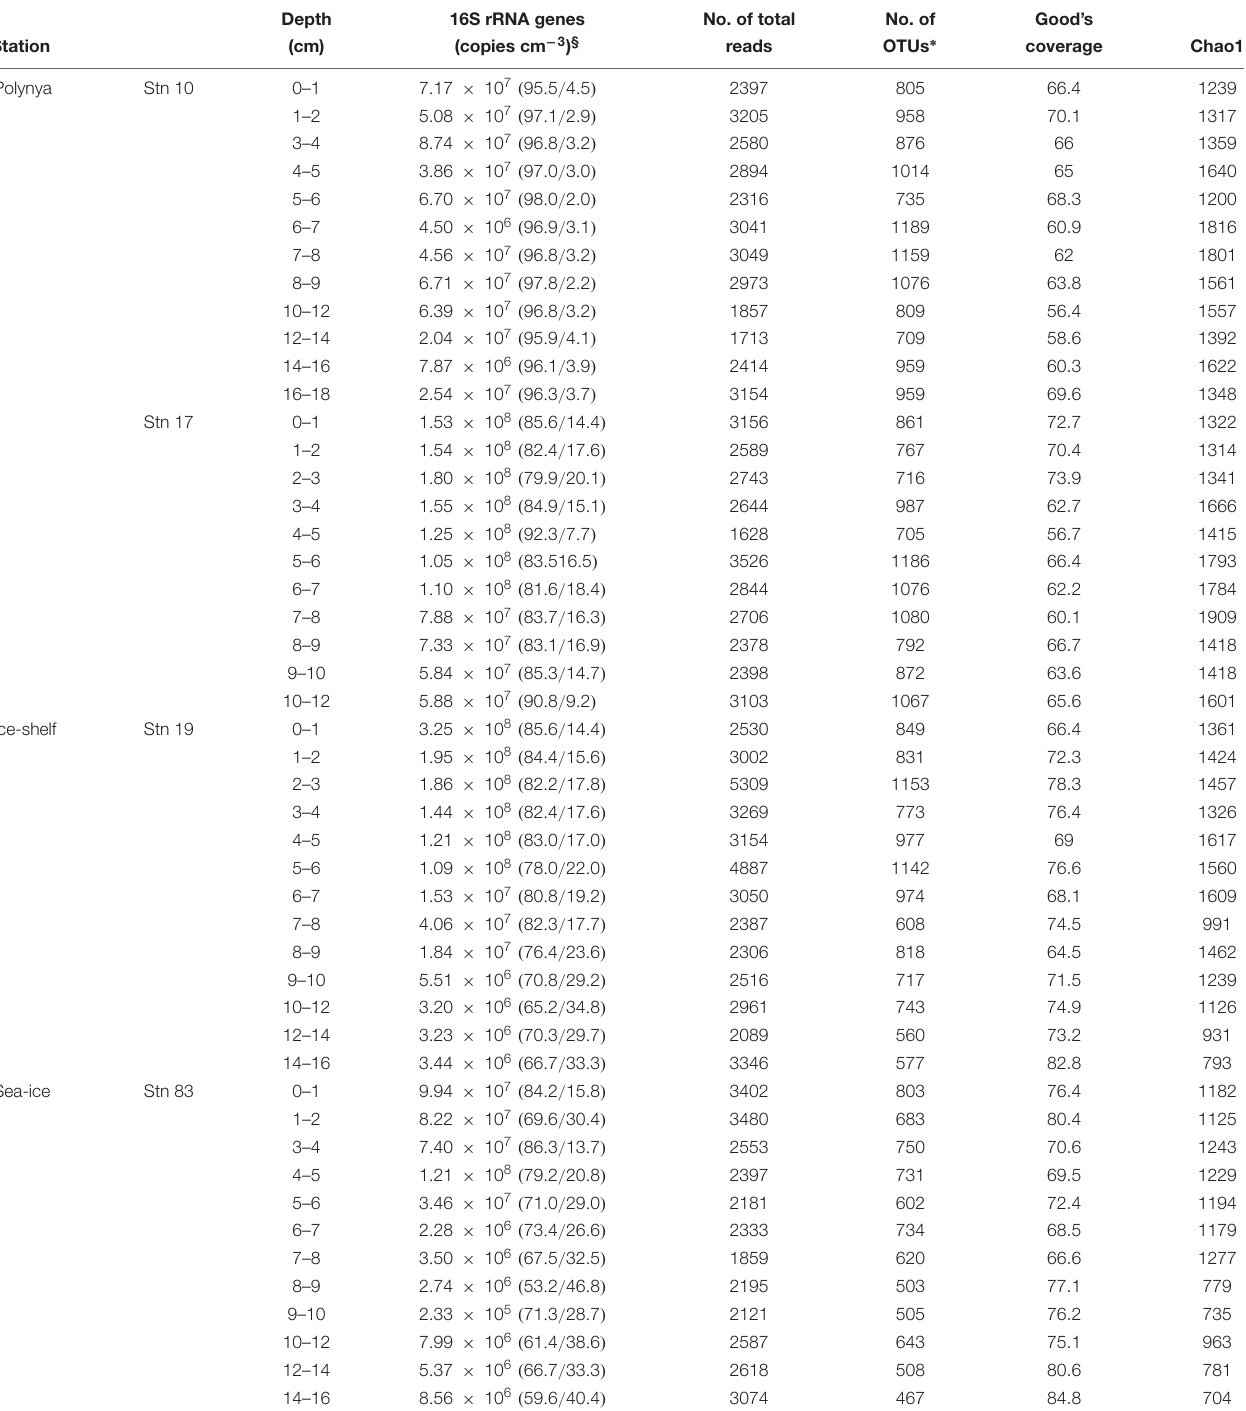
TABLE 2 | Prokaryotic abundance estimated by q-PCR and estimates of the richness and coverage.